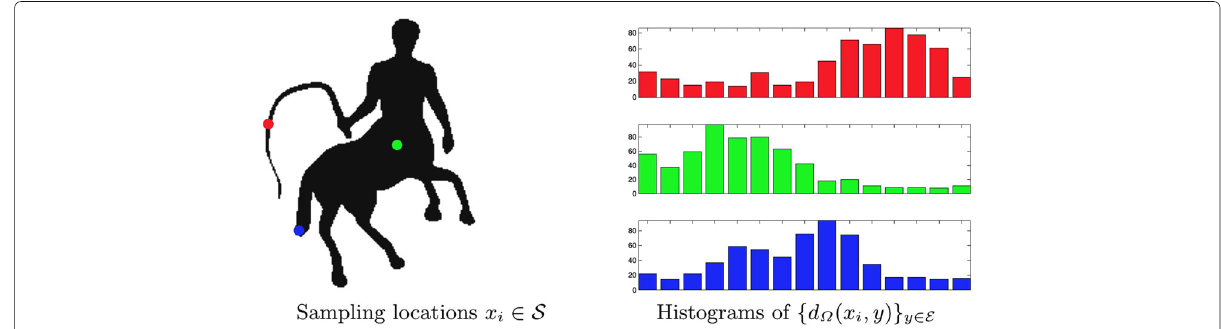
Fig. 5 Histogram of the distribution of the geodesic distance to several points [61]. The geodesics from seeds indicated by blue , green , and red propagate to all the points in the image, and their individual histogram distribution is depicted on the